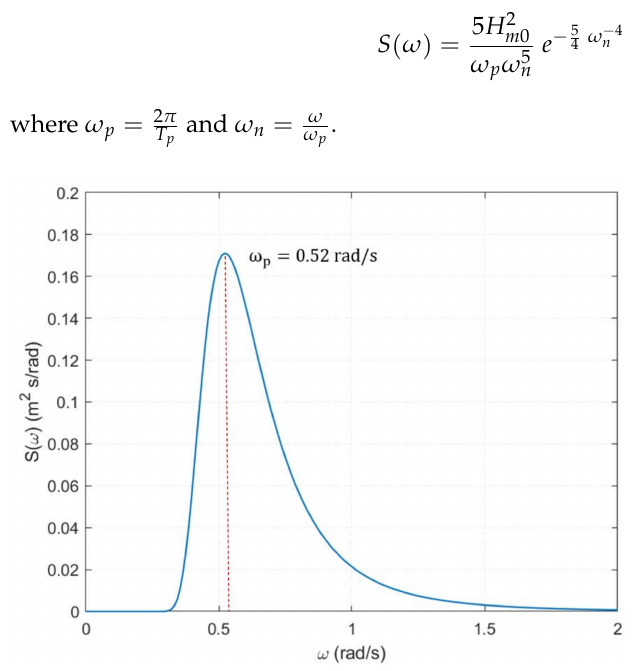
Figure 9. Spectral density computed using a PM spectrum for Hm0 = 1 m, Tp = 12